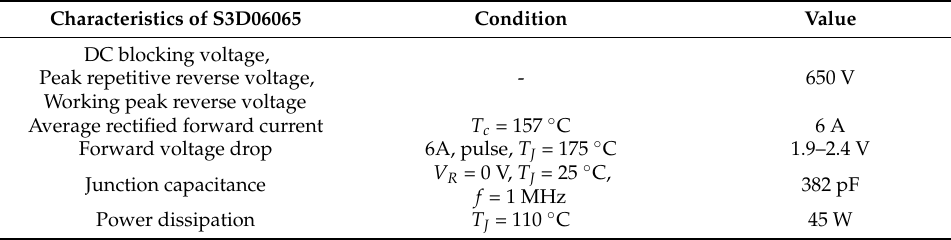
Table 5. Some characteristics of SiC Schottky diode